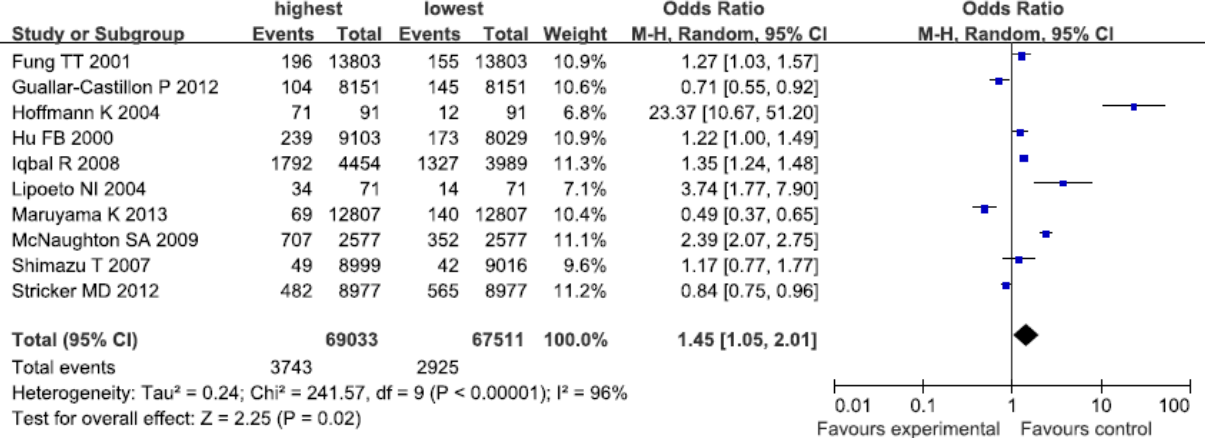
Figure 3. Forest plot of the highest compared with the lowest categories of intake of the unhealthy/Western-type dietary patterns and CHD risk.